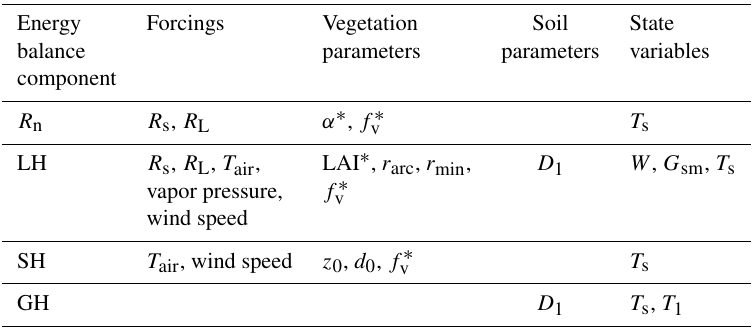
Table 2. List of spatially variable forcings, vegetation and soil parameters, and state variables involved in the computation of the energy balance (symbols defined in the main text and Appendix A). Forcings and state variables vary each hour. Parameters are either constant in time or vary each month (denoted with an asterisk ∗